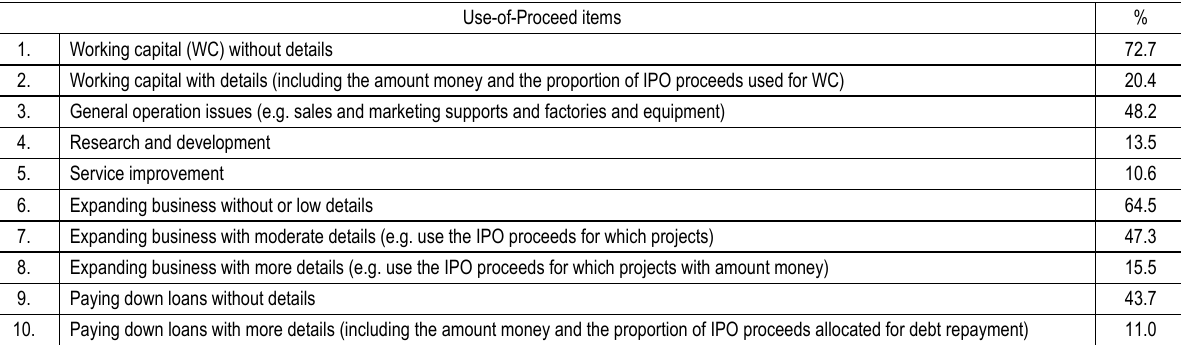
Table 2. The percentage of IPO companies disclosing use-of-proceeds information Use-of-Proceed